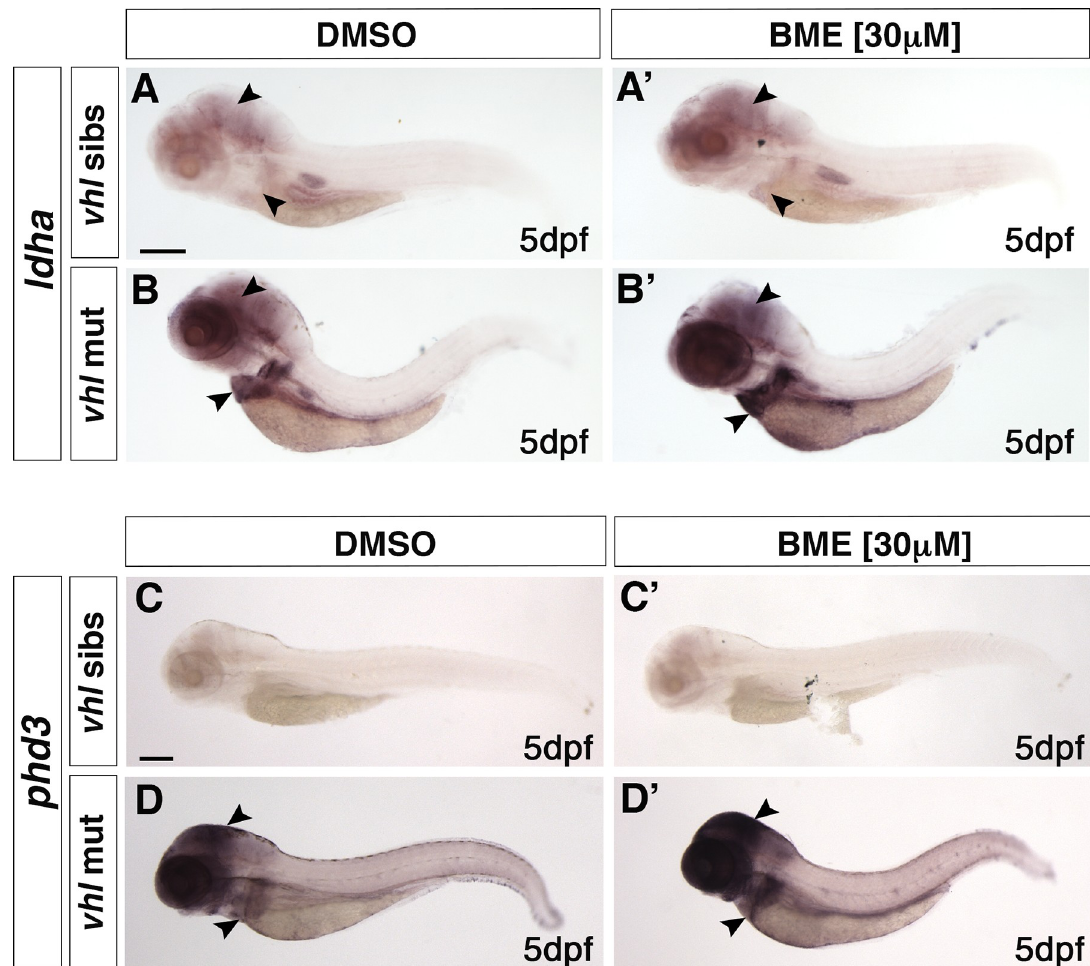
Fig 5. BME treatment is able to upregulate HIF signalling in vhl -/- . A-B’. Representative pictures of WISH performed on DMSO (A-B) and BME [30 μ M] (A’-B’) treated vhl +/- incross derived larvae, at 5 dpf, using ldha as probe. DMSO treated vhl siblings showed basal ldha expression (34/35 larvae), which showed to be upregulated after BME treatment (33/35 larvae). On the other hand, DMSO treated vhl -/- showed upregulated ldha expression (32/35 larvae), which was further upregulated after BME treatment (34/35 larvae). (black arrowhead: head and liver) Chi-square test ( ���� P < 0.0001). Scale bar 200 μ m. C-D’. Representative pictures of WISH performed on DMSO (C-D) and BME [30 μ M] (C’-D’) treated vhl +/- incross derived larvae, at 5 dpf, using phd3 (egln3) as probe. As expected, vhl siblings DMSO treated (n = 30/30 larvae) showed basal phd3 expression, which was mildly increased after BME treatment (n = 27/30 larvae). Vhl -/- DMSO treated (n = 28/30 larvae) showed upregulated phd3 e xpression, which was further increased after BME treatment (n = 26/30 larvae). (black arrowhead: head and liver) Chi-square test ( ���� P < 0.0001). Scale bar 200 μ